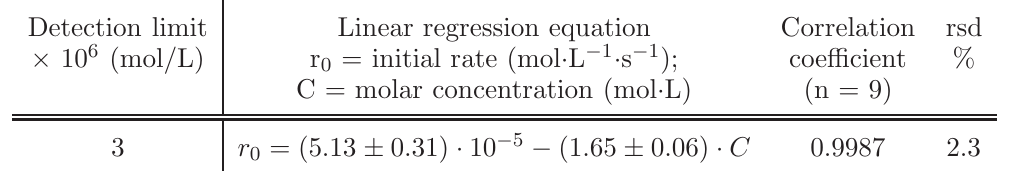
Table 2 Features of calibration graphs for the determination of para